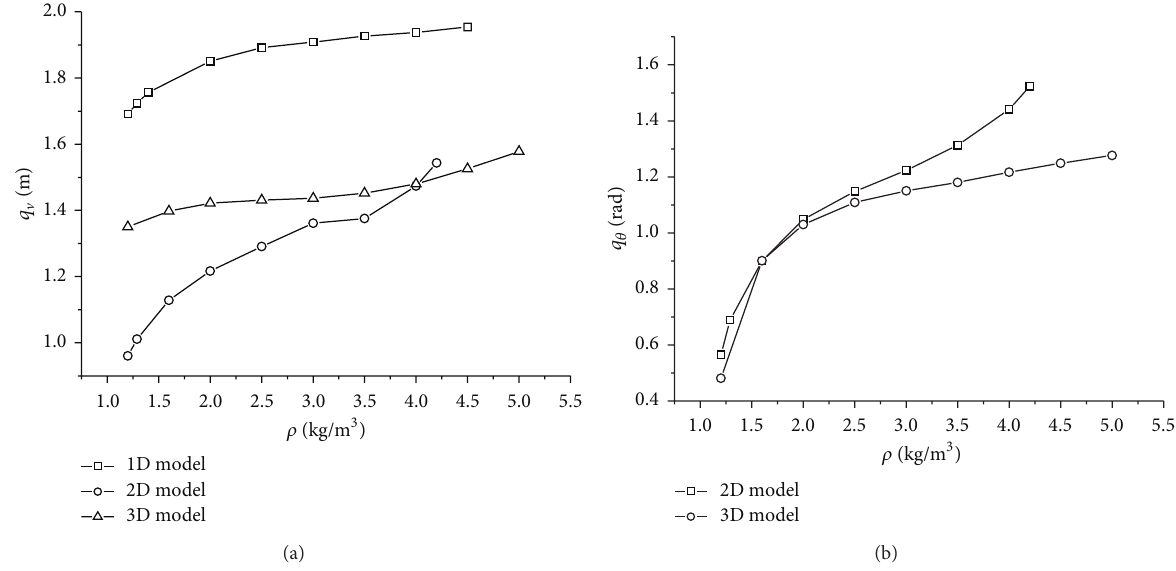
Figure 6: The influence of the flow density on the galloping amplitude: (a) vertical amplitude and (b) torsional